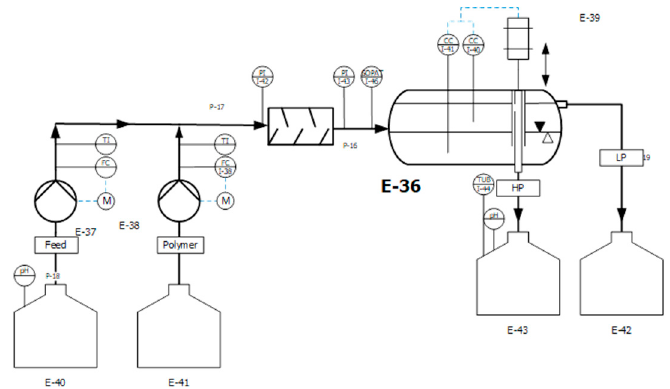
Figure 8. Illustration of the structure of the continuous settler.